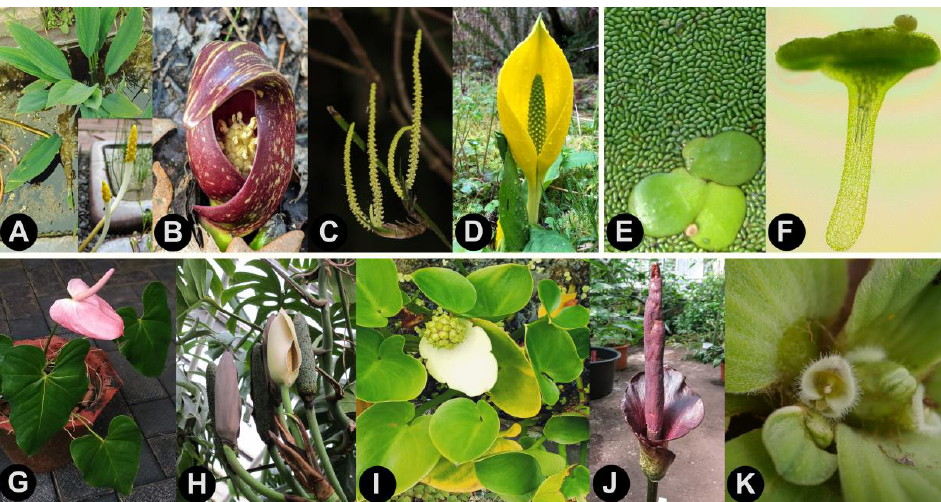
Figure 1. Species of Arales, divided among the family-level categories that are described herein: Orontiaceae ( A – D ), Lemnaceae ( E , F ), and Araceae ( G – K ). ( A ) Vegetative growth and inflorescence (inset) of Orontium aquaticum (photo credit: Wolfgang Pomper), ( B ) Symplocarpus foetidus (photo credit: Claire O’Neill), ( C ) Inflorescence of Gymnostachys anceps (photo credit: Leith Woodall), ( D ) Lysichiton americanus with inflorescence (photo credit: Ryan Kurtz), ( E ) Fronds of Spirodela polyrhiza surrounded by Wolffia globosa , ( F ) Light micrograph of Wolffia microscopica bearing the floral organs on the dorsal side (anther lobes seen on the top), ( G ) Anthurium andraeanum with inflorescence, ( H ) Monstera deliciosa with inflorescence (photo credit: Wolfgang Pomper), ( I ) Calla palustris with inflorescence, ( J ) Amorphophallus konjac with inflorescence (photo credit: Wolfgang Pomper), ( K ) Inflorescence of Pistia stratiotes (photo credit: Bo-Fu